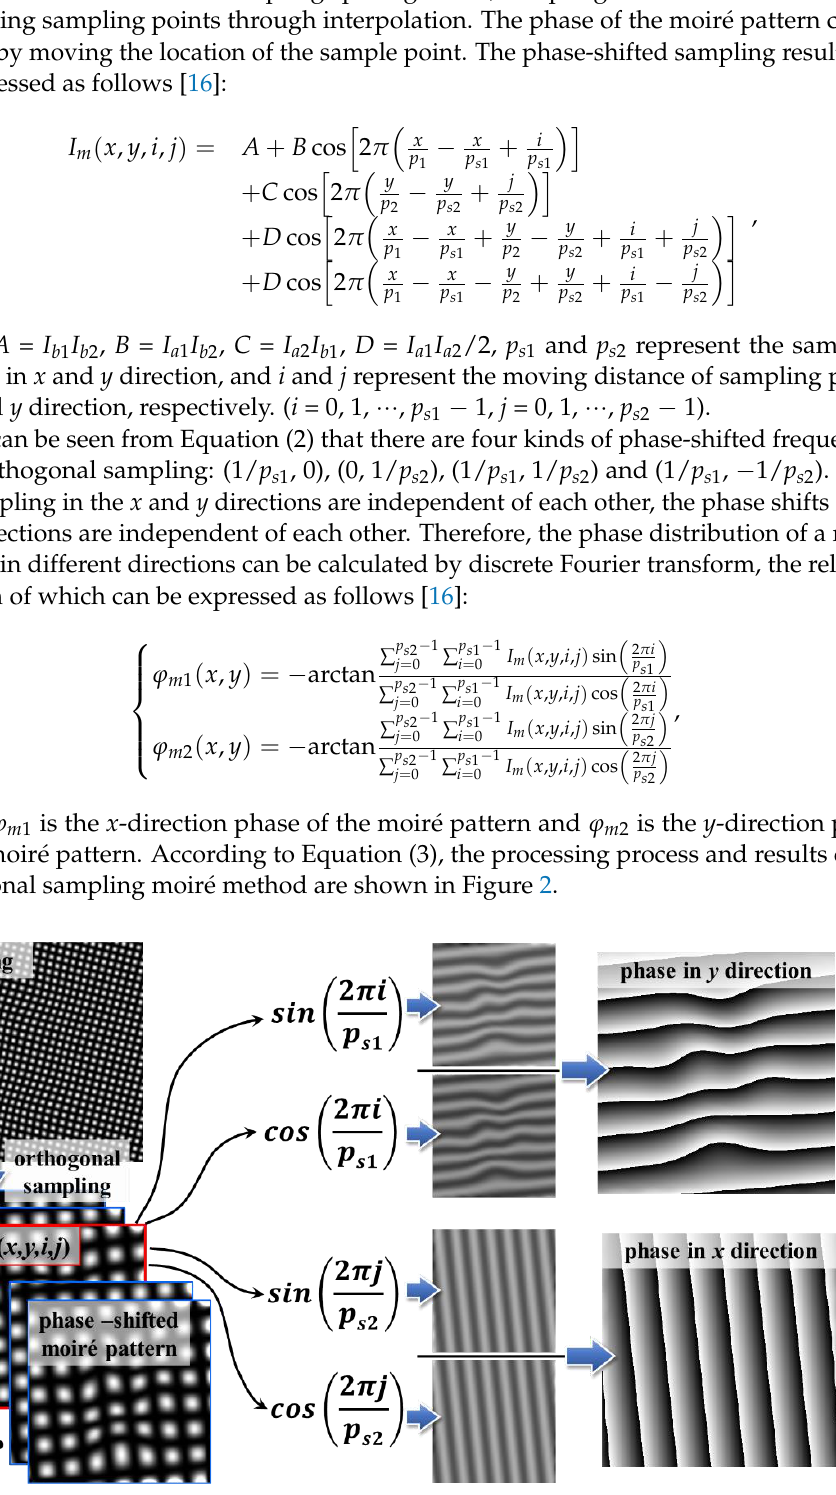
Figure 2. Phase results in two directions by orthogonal sampling.